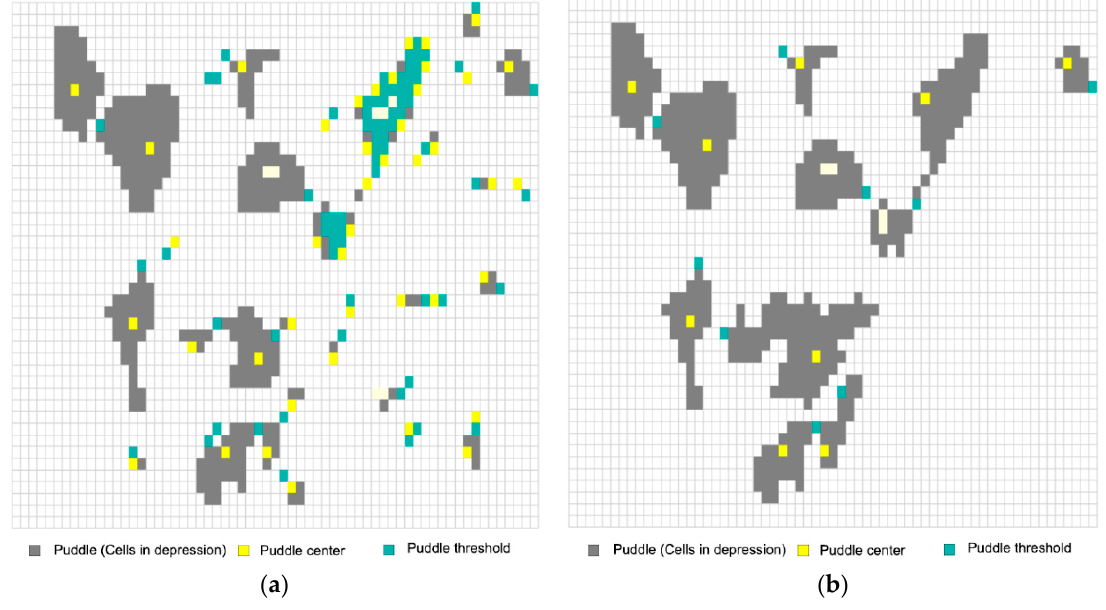
Figure 12. ( a ) Delineated depressions and flats based on the DEM with an accuracy of three decimal digits; and ( b ) delineated depressions and flats using the new DEM after correcting small depressions/flats.